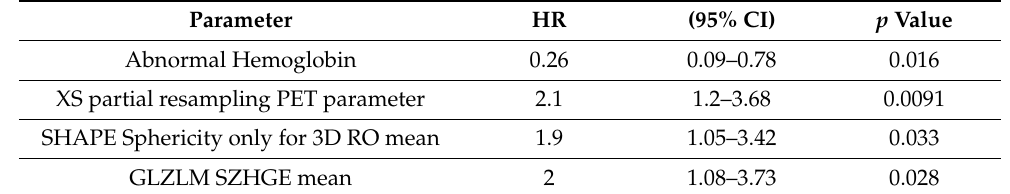
Table 8. MVA models for radiotherapy outcome.